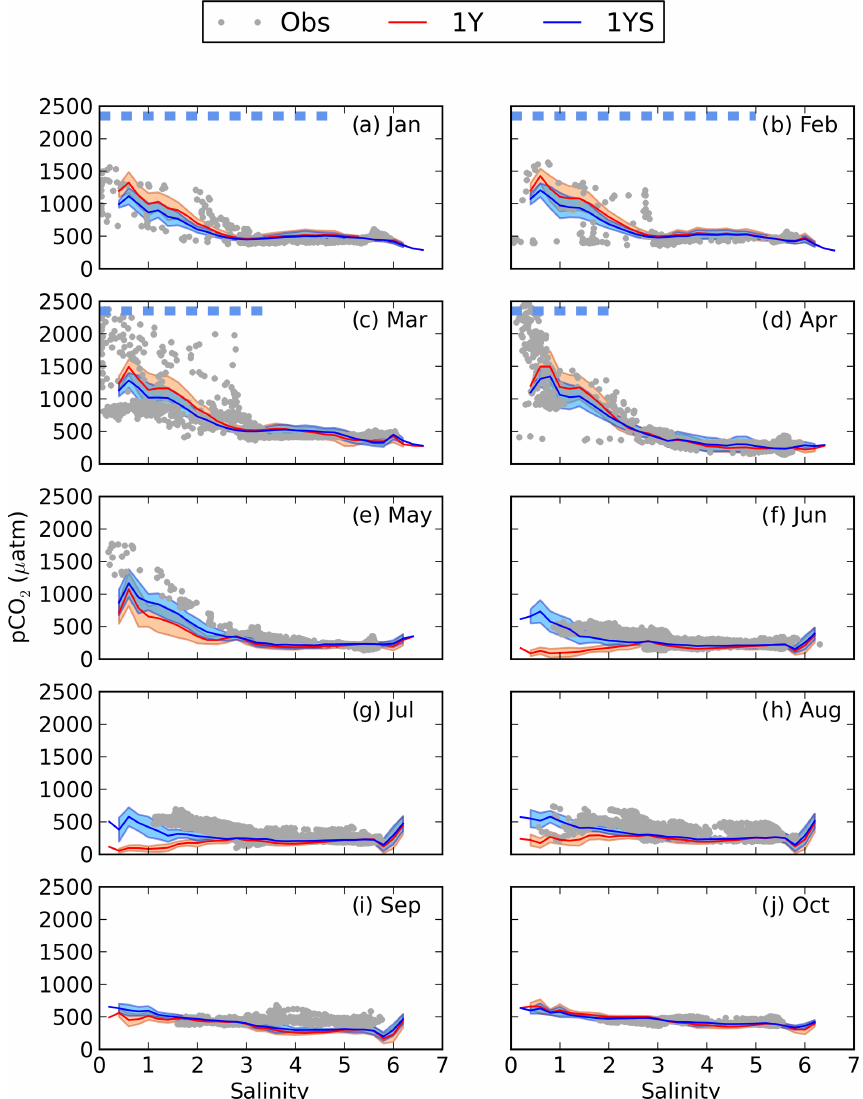
Figure 8. p CO 2 –salinity relationships for January–October ( a–j ). Grey dots show observed values. The red and blue lines show modelled climatological monthly means for the 1Y and 1YS experiments, with the shaded area displaying the standard deviation at a given salinity. The dashed blue line shows the ice extent (salinities at which the ice concentration is larger than